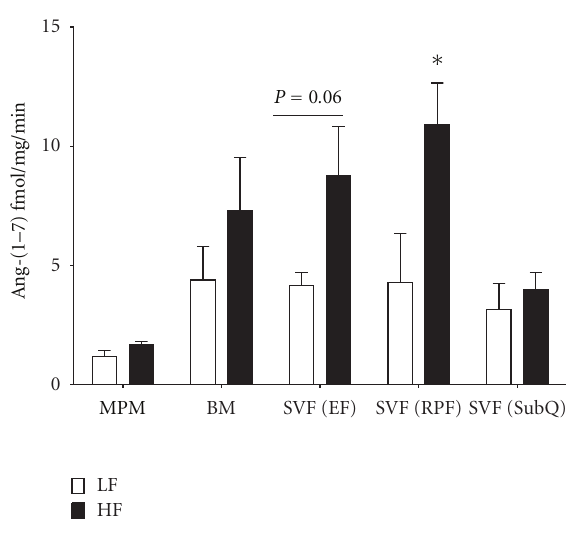
Figure 1: ACE2 activity is increased in the stromal vascular fraction (SVF) isolated from visceral adipose tissue of HF-fed C57BL/6 mice. ACE2 activity was quantified in mouse peritoneal macrophages (MPMs), bone marrow (BM), and SVF isolated from epididymal (EF), retroperitoneal (RPF) or subcutaneous (SubQ) adipose tissue from LF or HF-fed mice. Data are mean ± SEM from N = 3-4 mice/diet group. ∗ : P < 0 . 05 compared to LF.